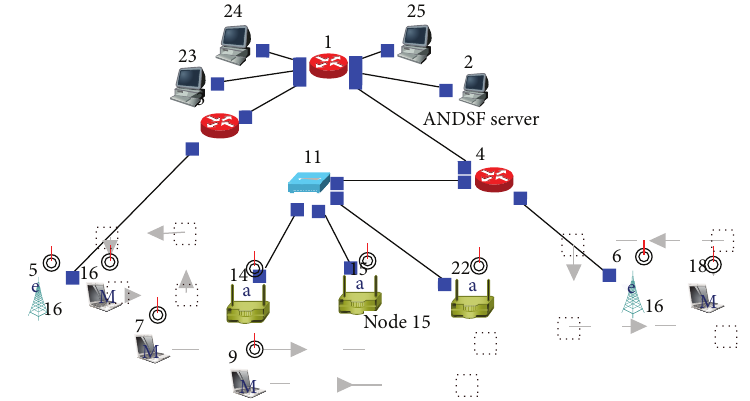
or WiFi, it does not support VHO between WiMAX